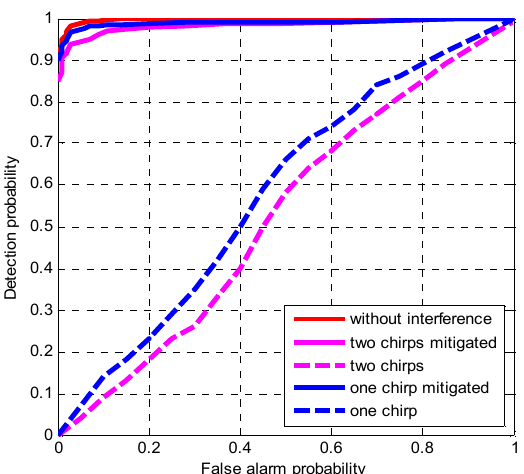
Figure 7. ROC curves for BDS B1I signals affected by chirp interference. The JNR is 12 dB, the C / N 0 is 43 dB-Hz. The coherent integration time is 1 ms.